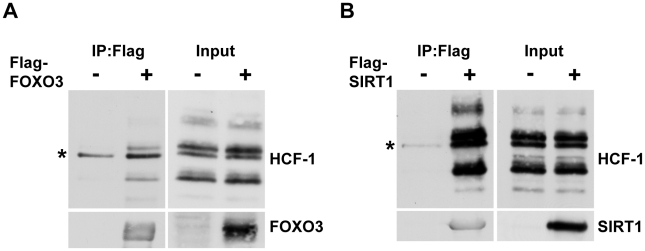
Mammalian HCF-1 physically associates with FOXO3 and SIRT1.(A, B) HEK293T cells were transfected with plasmids encoding Flag-FOXO3 (A) or Flag-SIRT1 (B). Cell lysates were collected 48 hours later and incubated with anti-Flag-conjugated agarose beads. Immunoprecipitated protein complexes were analyzed by western blot using anti-HCF-1, anti-FOXO3 or anti-SIRT1 antibodies. HCF-1 is known to be proteolytically processed and is detected as multiple bands on SDS-PAGE [76]. * denotes a non-specific band.